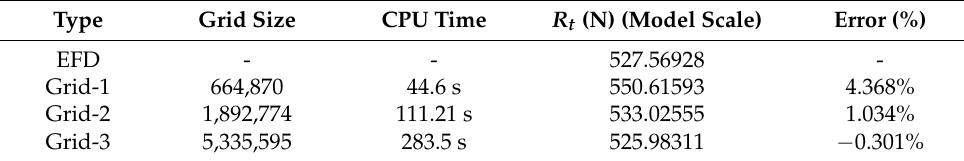
Table 3. Resistance calculation results under different mesh conditions.